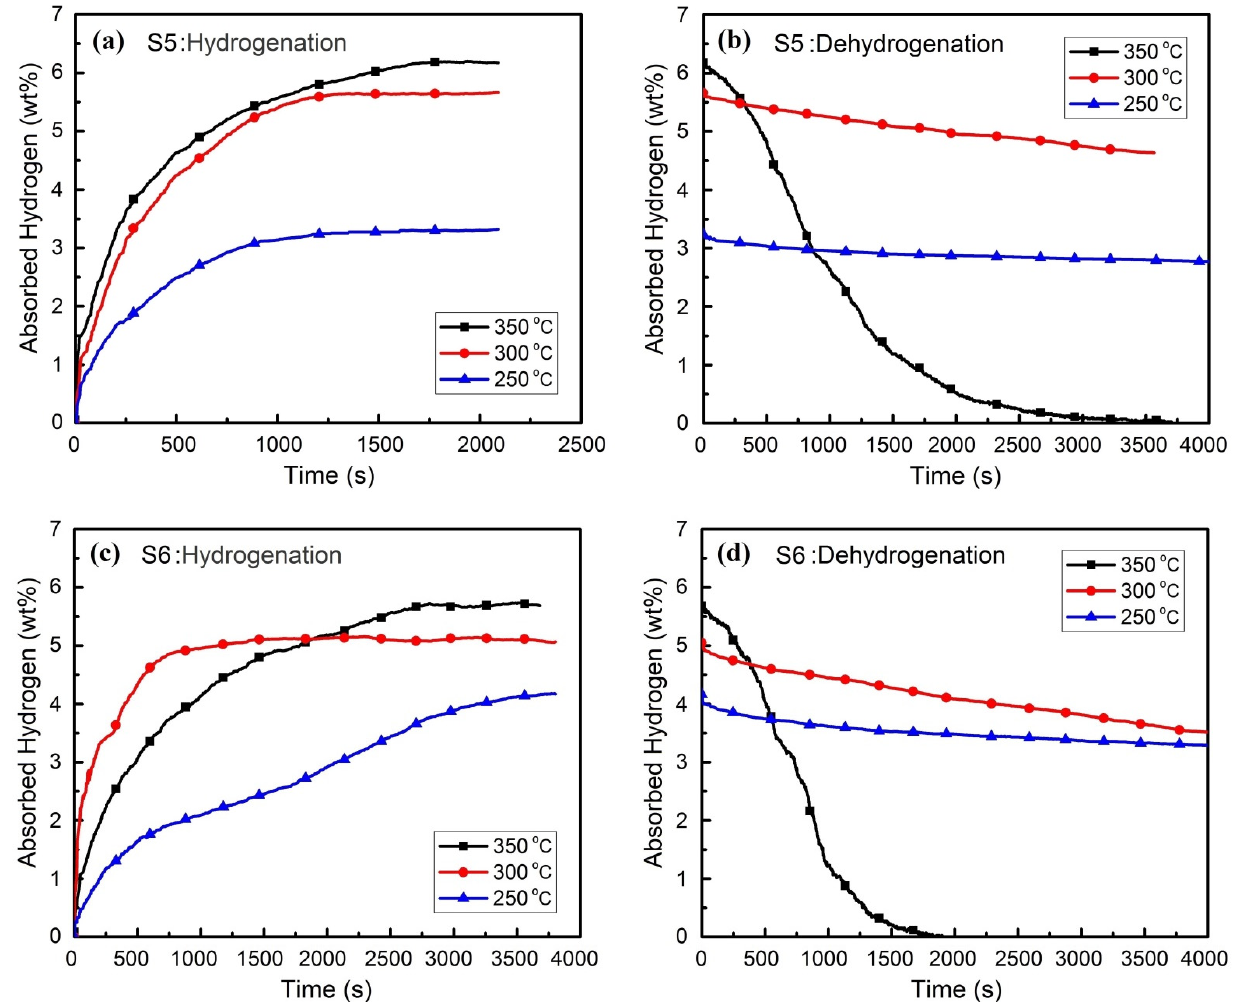
Figure 5 . Hydrogenation kinetics at 30 bar and dehydrogenation kinetics at 10 − 1 mbar for different temperatures: ( a , b ) S5 sample (third pass of TPCAE at 250 °C); ( c , d ) S6 sample (fourth pass of TPCAE at 200 °C).